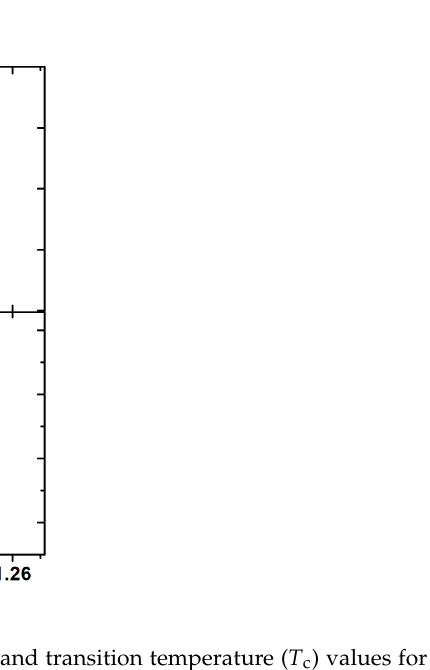
Figure 6. Upper critical field ( H c2 ) and transition temperature ( T c ) values for the reported single crystal and polycrystalline 1111 ( RE FeAsO; RE = rare earth) family with respect to the ionic radius of rare earth RE are depicted. The data have been taken from Tables 1 and 2.